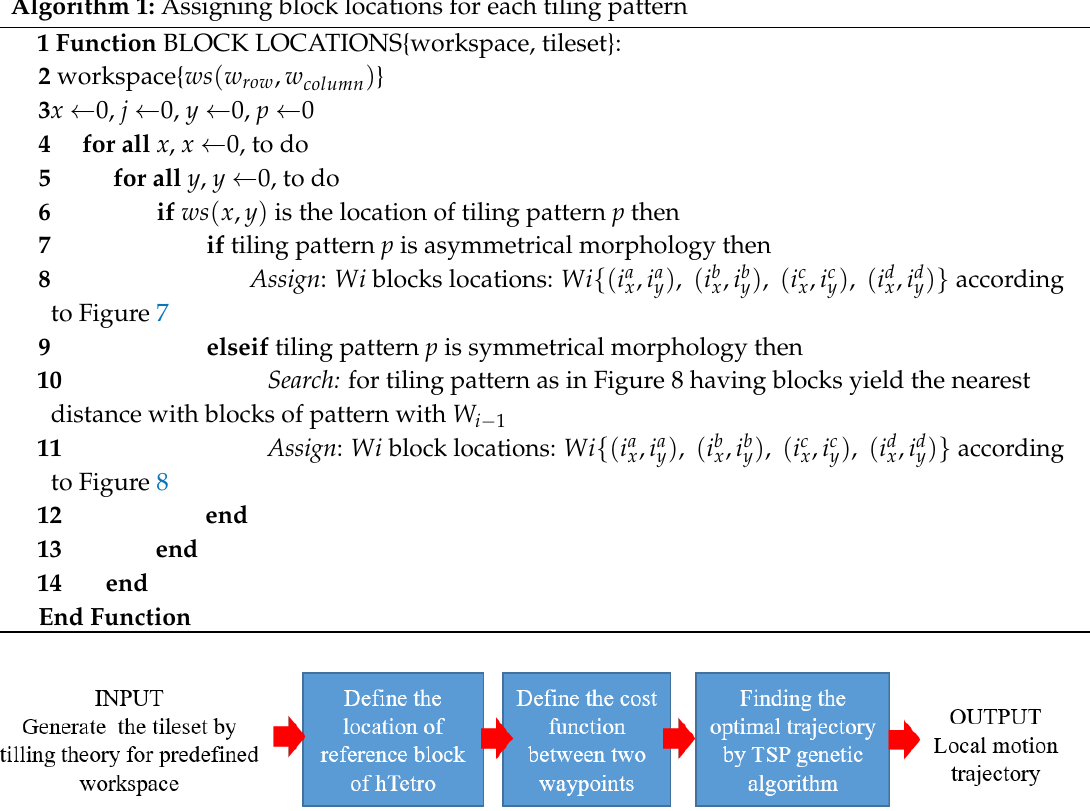
Algorithm 1: Assigning block locations for each tiling pattern